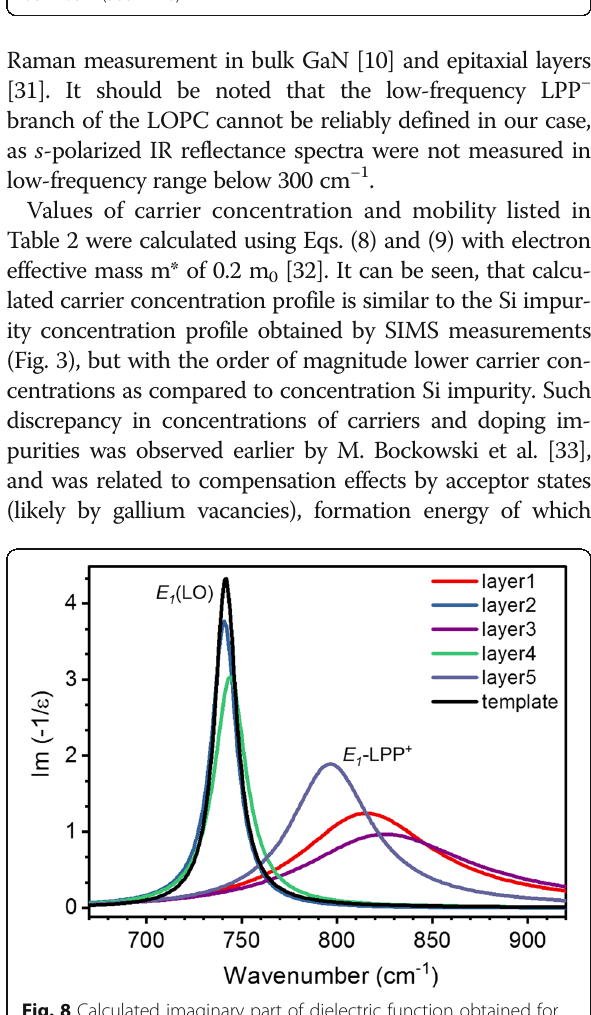
Fig. 7 Experimental ( solid line ) IR reflectance spectra of the investigated n + /n 0 /n + -GaN structure and calculated reflectance spectra of 6.78- μ m-thick GaN layer on sapphire ( dash-dot line ) and bulk GaN ( dash line )